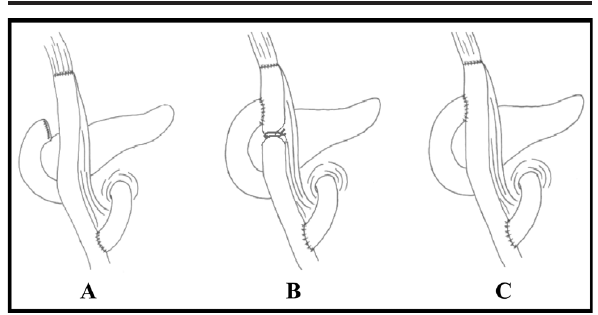
FIGURE 1 - Techniques of intestinal reconstruction after total gastrectomy. A: Roux-en-Y B: Rosanov